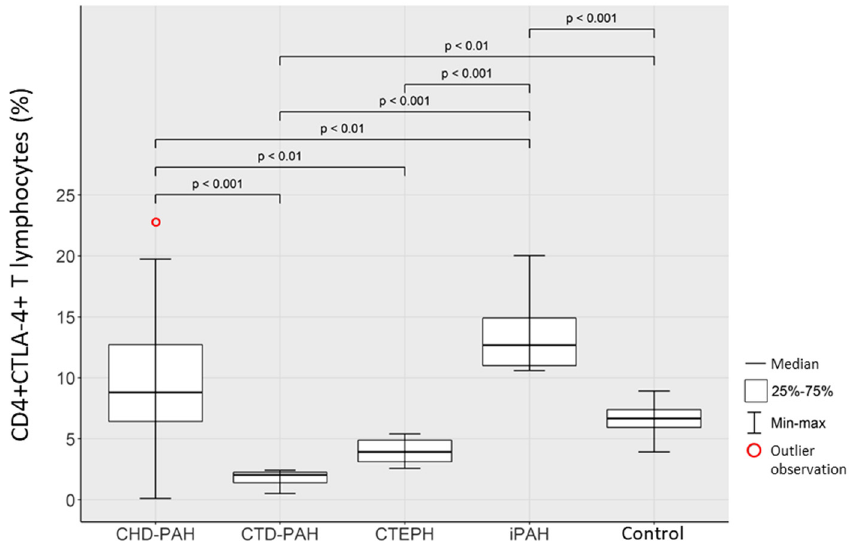
Figure 2. Percentage of CD4+CTLA4+ T lymphocytes in CHD-PAH, CTD-PAH, CTEPH, iPAH patients and control subjects. Comparison of the percentage of CD8+CTLA4+ T lymphocytes in selected types of